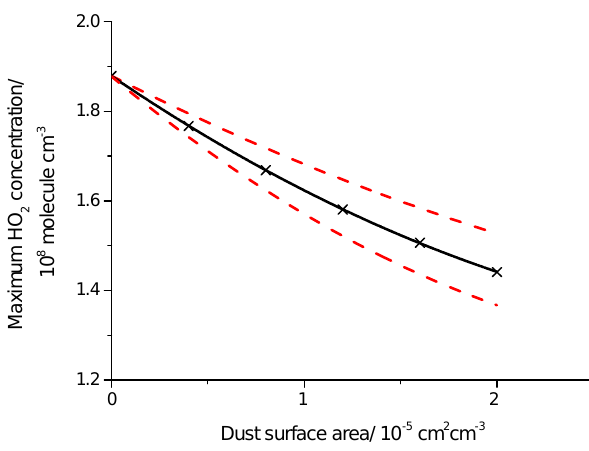
Figure 9. The decrease of the solar noon maximum HO 2 concentration (crosses with solid black line) with dust surface area calculated by a box model utilising the Master Chemical Mechanism and constrained to conditions at the Cape Verde Atmospheric Observatory. An HO 2 uptake coefficient of 0.031 was used in these calculations, and the dashed red lines represent the HO 2 concentrations calculated with the ± 0.008 error in the uptake